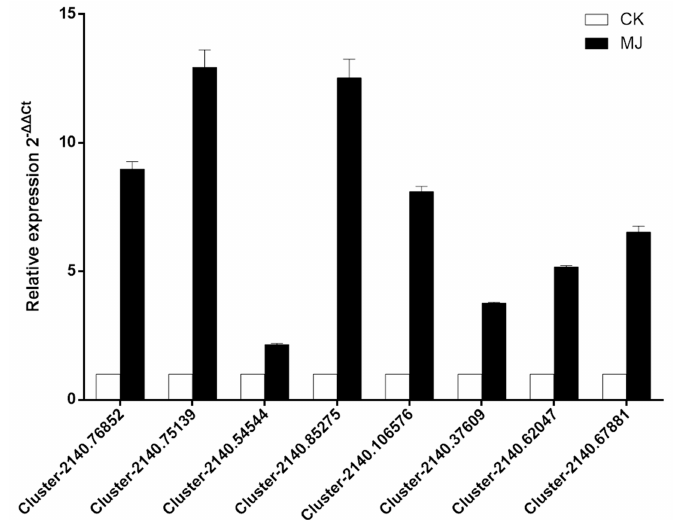
Figure 6. Real-time PCR analysis of several candidate unigenes between the 24 h MeJA-treated and the 24 h control samples. The candidate unigenes included one coding for HMGS (cluster-2140.76852), one for SS (cluster-2140.75139), three for CYPs (cluster-2140.54544, cluster-2140.85275 and cluster-2140.106576), and three for TFs (cluster-2140.37609, cluster-2140.62047, and cluster-2140.67881). CK: the 24 h control samples. MJ: the 24 h MeJA-treated samples.